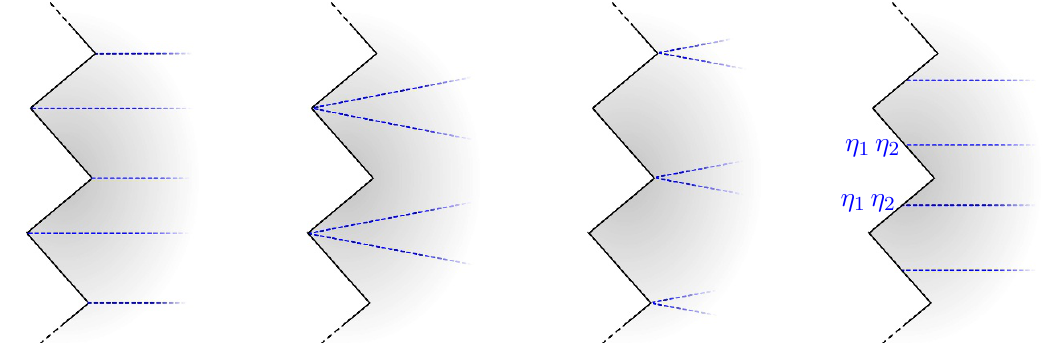
Figure 11 . All possible ways how scalar propagators can attach themselves to a Wilson line for the hybrid parametrization (5.17). The second and third contributions belong to the same double cusp